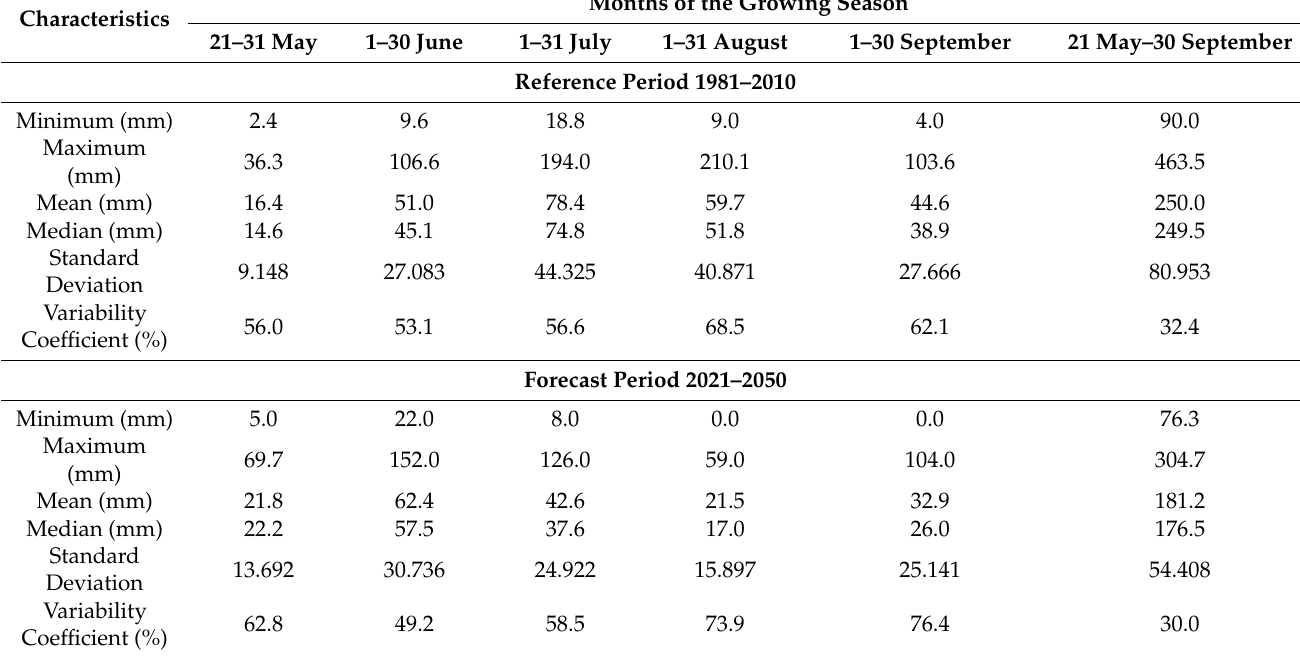
Table 3. Statistical characteristics of the rainfall amount in the growing season for the reference and forecast years.